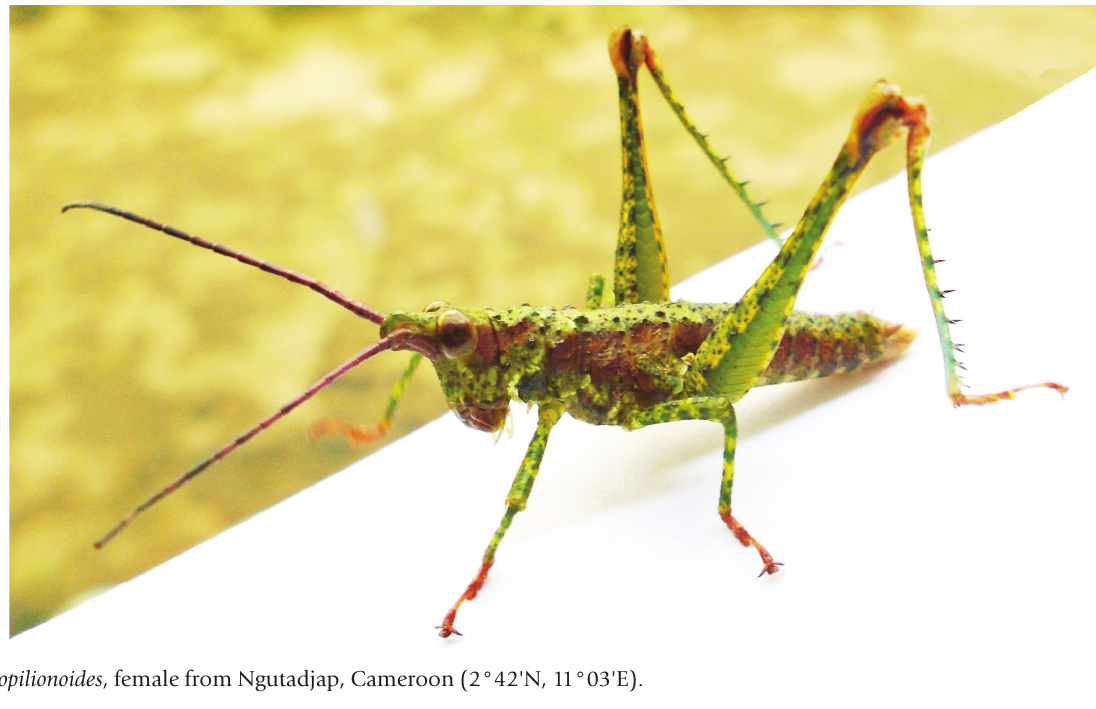
Fig. 4. G. opilionoides , female from Ngutadjap, Cameroon (2°42'N, 11°03'E).